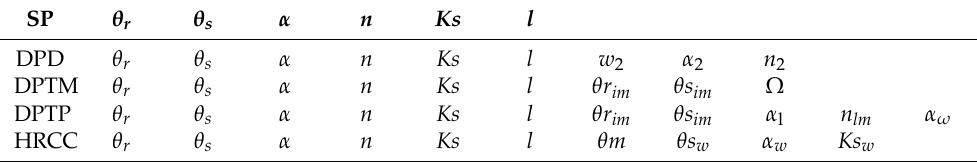
Table 3. Soil hydraulic parameters used in each model SP, DPD, DPTM, DPTP, and